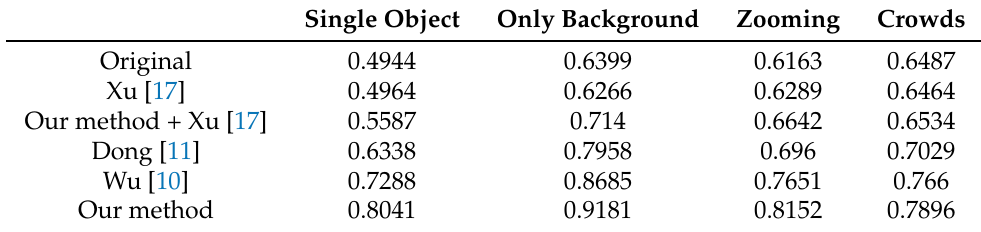
Figure 8. Average SSIM of different methods in four groups shaky videos. Table 5. Average SSIM Comparison of different methods in four groups shaky